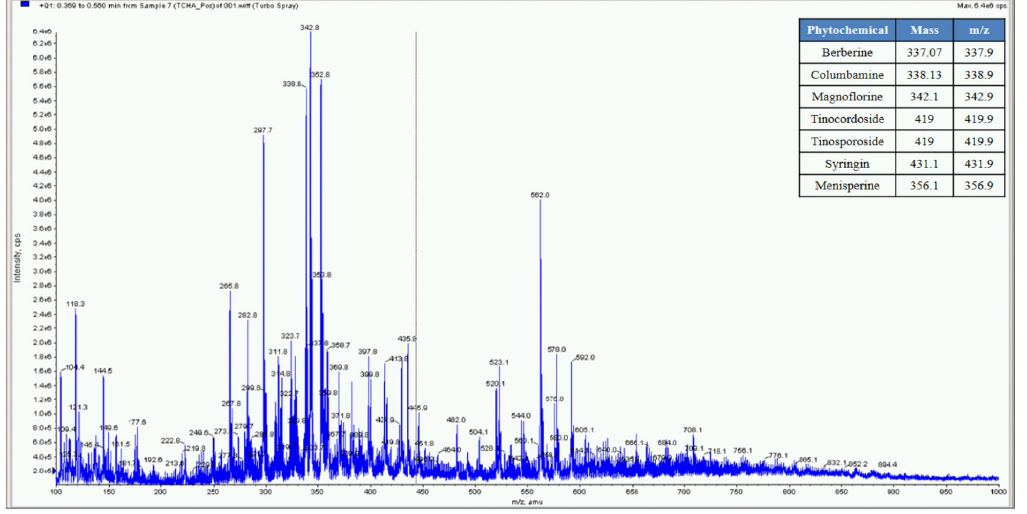
Fig 7. Mass spectrometer fingerprinting of Tinospora cordifolia hydro-alcoholic extract (TCHA).